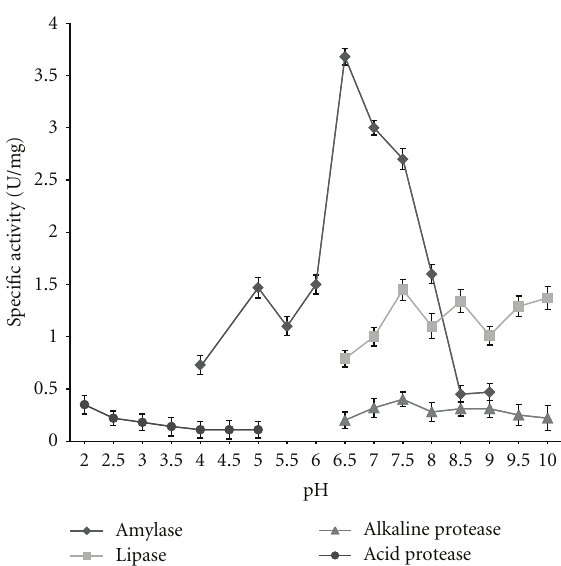
Figure 2: E ff ect of temperature on the activity of amylase, lipase, alkaline,and acid proteases in the hepatopancreas ofcrayfish Cherax albidus juveniles. Gastric juice and intestine gave similar results. Values are reported as means ± SEM. Assays were performed on three samples in